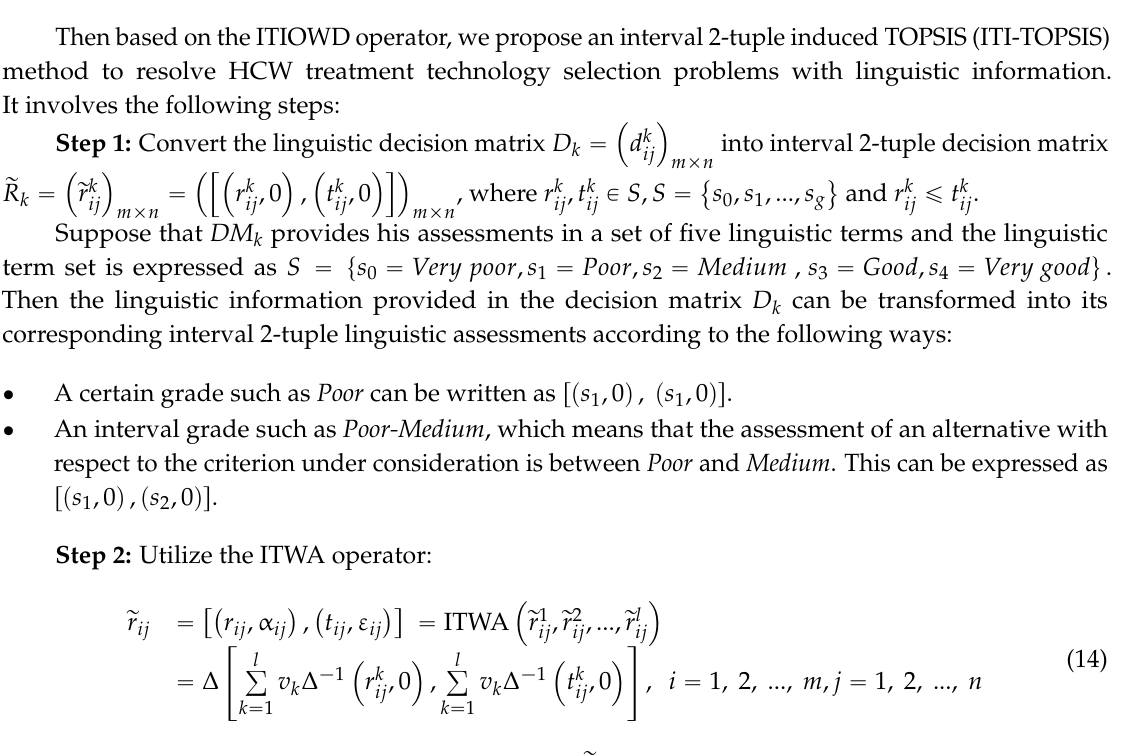
Figure 1. Flowchart of the proposed ITI-TOPSIS method.